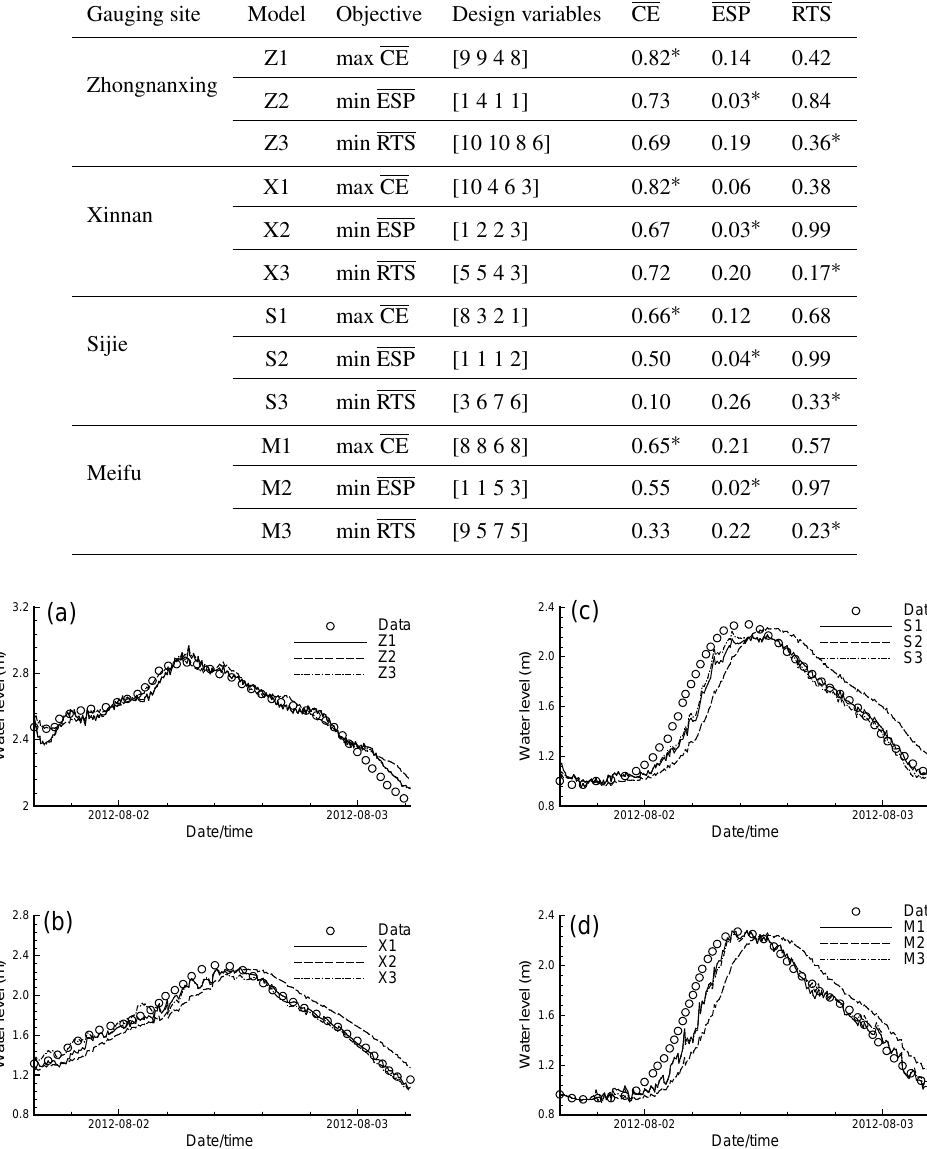
Figure 6. Comparison of model predictions (3h lead time) and measured data at (a) Zhongnanxing station; (b) Xinnan station; (c) Sijie station; (d) Meifu